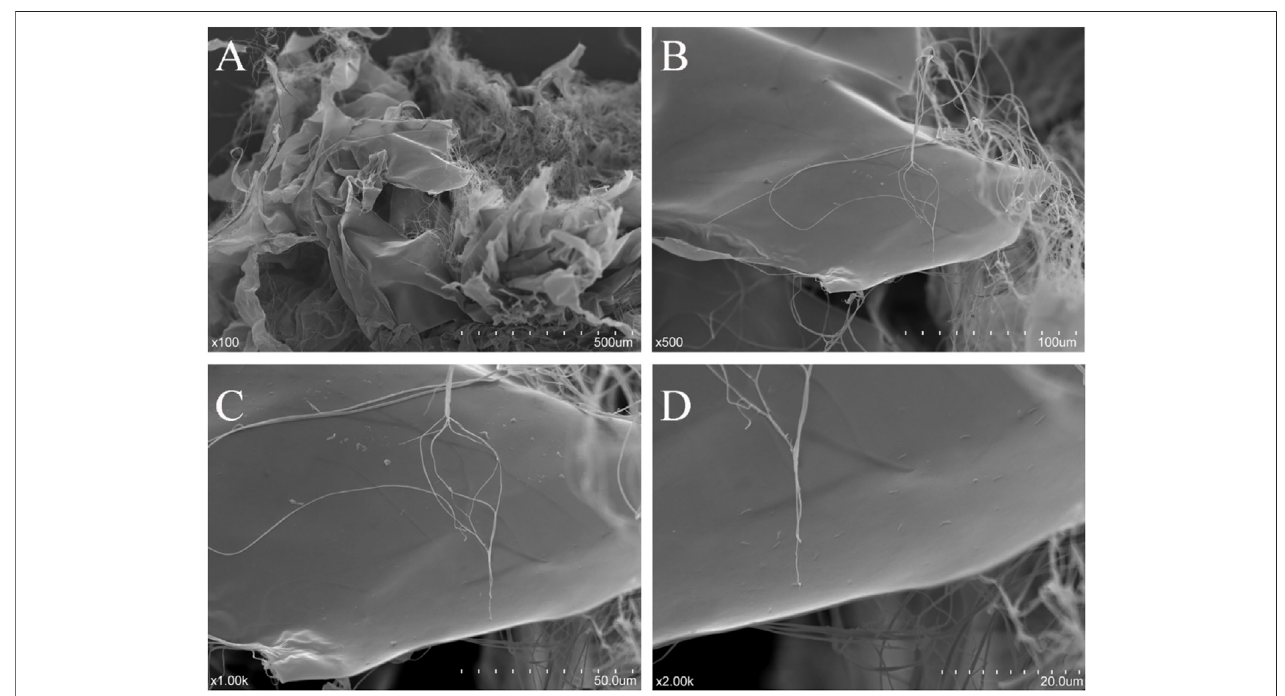
FIGURE 5 | Scanning electron micrographs of NHSP [ (A) : ×100; (B) ×500; (C) ×1,000; and (D) ×2000].